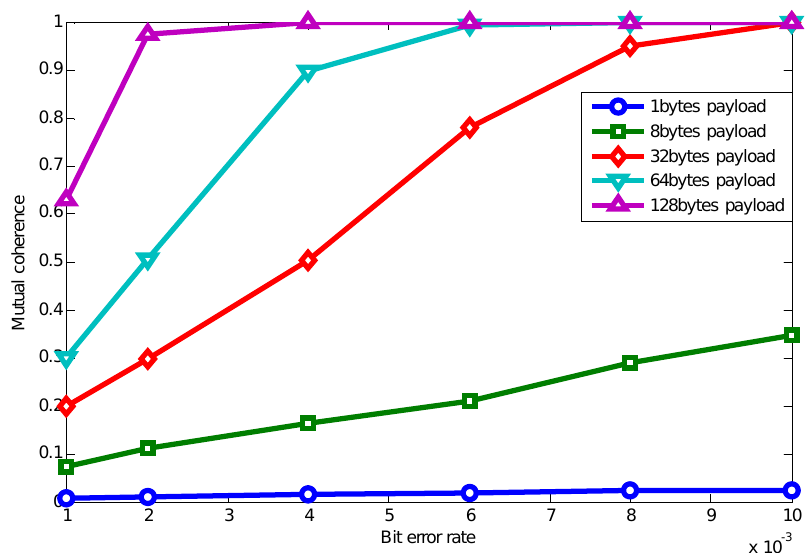
Figure 9. Packet length effect on the relationship between BER and mutual coherence using RCS